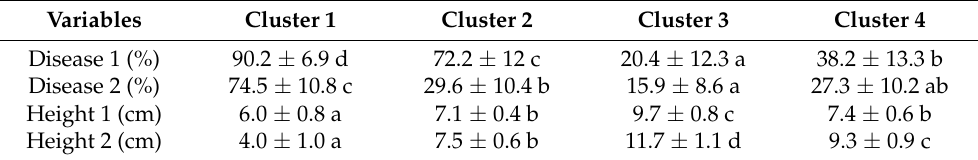
Table 2. Cluster analyses of sunflowers inoculated with different P. halstedii isolates based on disease rates and plant heights.